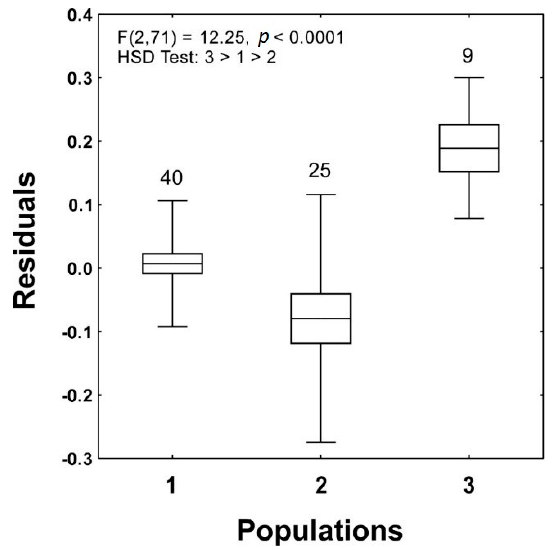
Figure 4. Variation in body condition across the three H. ambrosii populations. Boxes represent the ranges between first and third quartiles, horizontal bars inside the boxes represents the means, and whiskers embrace the full spectrum of data. Numbers on the tops of the whiskers represent the number of analysed salamanders. Top left: the results of one-way ANOVA and Tukey HSD tests assessing the significant difference among populations.